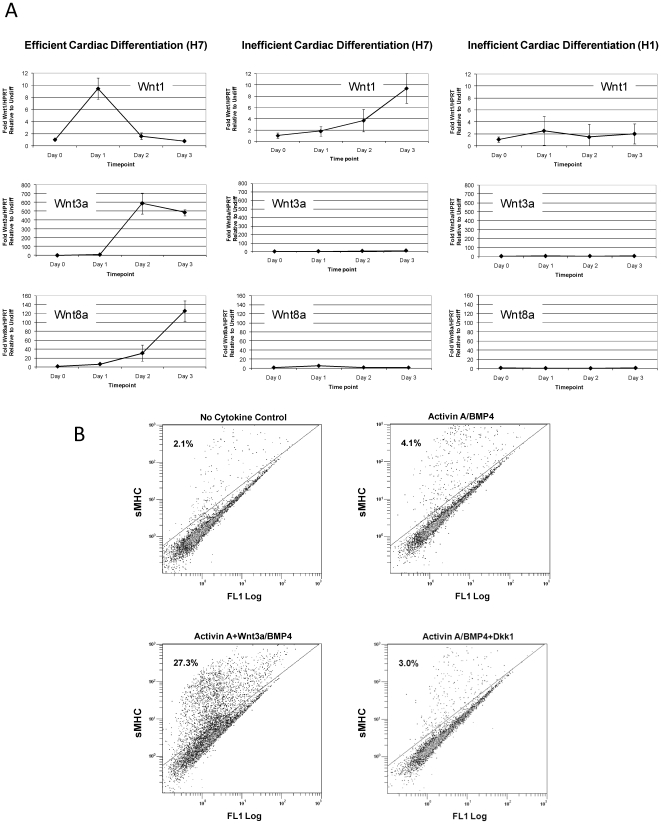
Canonical Wnt expression during mesoderm specification correlates with the efficiency of cardiac differentiation.Quantitative RT-PCR for canonical Wnt ligands Wnt1, Wnt3a and Wnt8a. Data are presented as mean fold expression normalized to HPRT relative to undifferentiated cells. (A) Representative of cultures of H7 hES cells that showed efficient and inefficient directed differentiation to cardiomyocytes (>25% and <5% sMHC+, respectively), as well as H1 hES cells that are poorly cardiogenic. (B) Cultures that routinely generated <5% cardiomyocytes were treated with Wnt3a or Dkk1 in addition to activin A and BMP4. After 17 days of differentiation following activin A treatment, cells were stained for sMHC. Exogenous Wnt3a partially rescued inefficient cardiac differentiation.